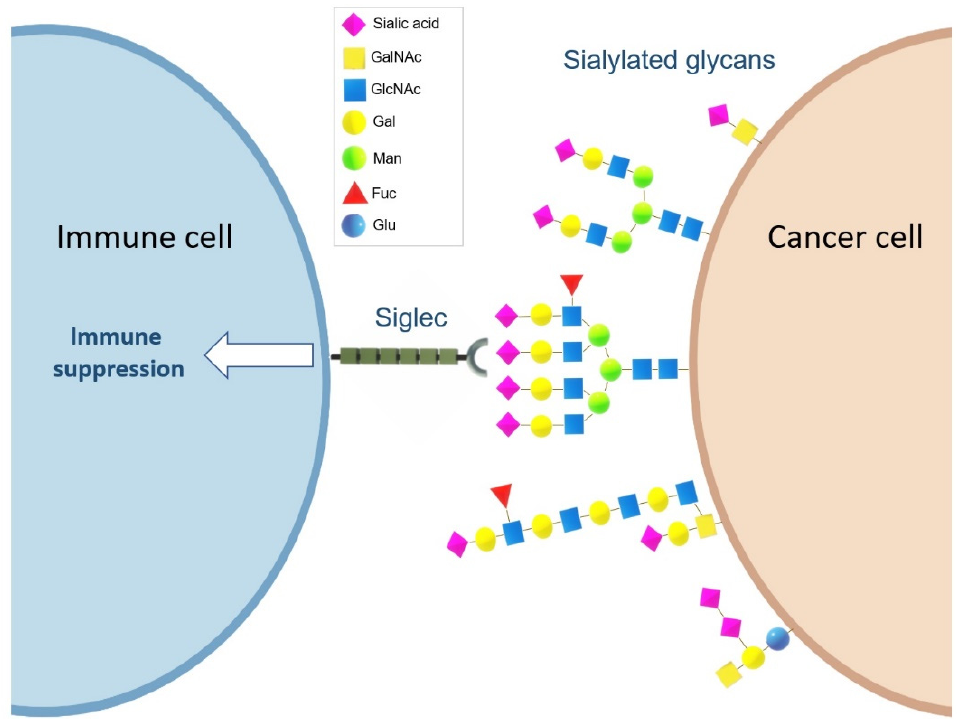
Figure 2. Siglec–sialoglycan interactions can modulate immune cell function and promote an im- munosuppressive tumour microenvironment (TME). munosuppressive tumour microenvironment